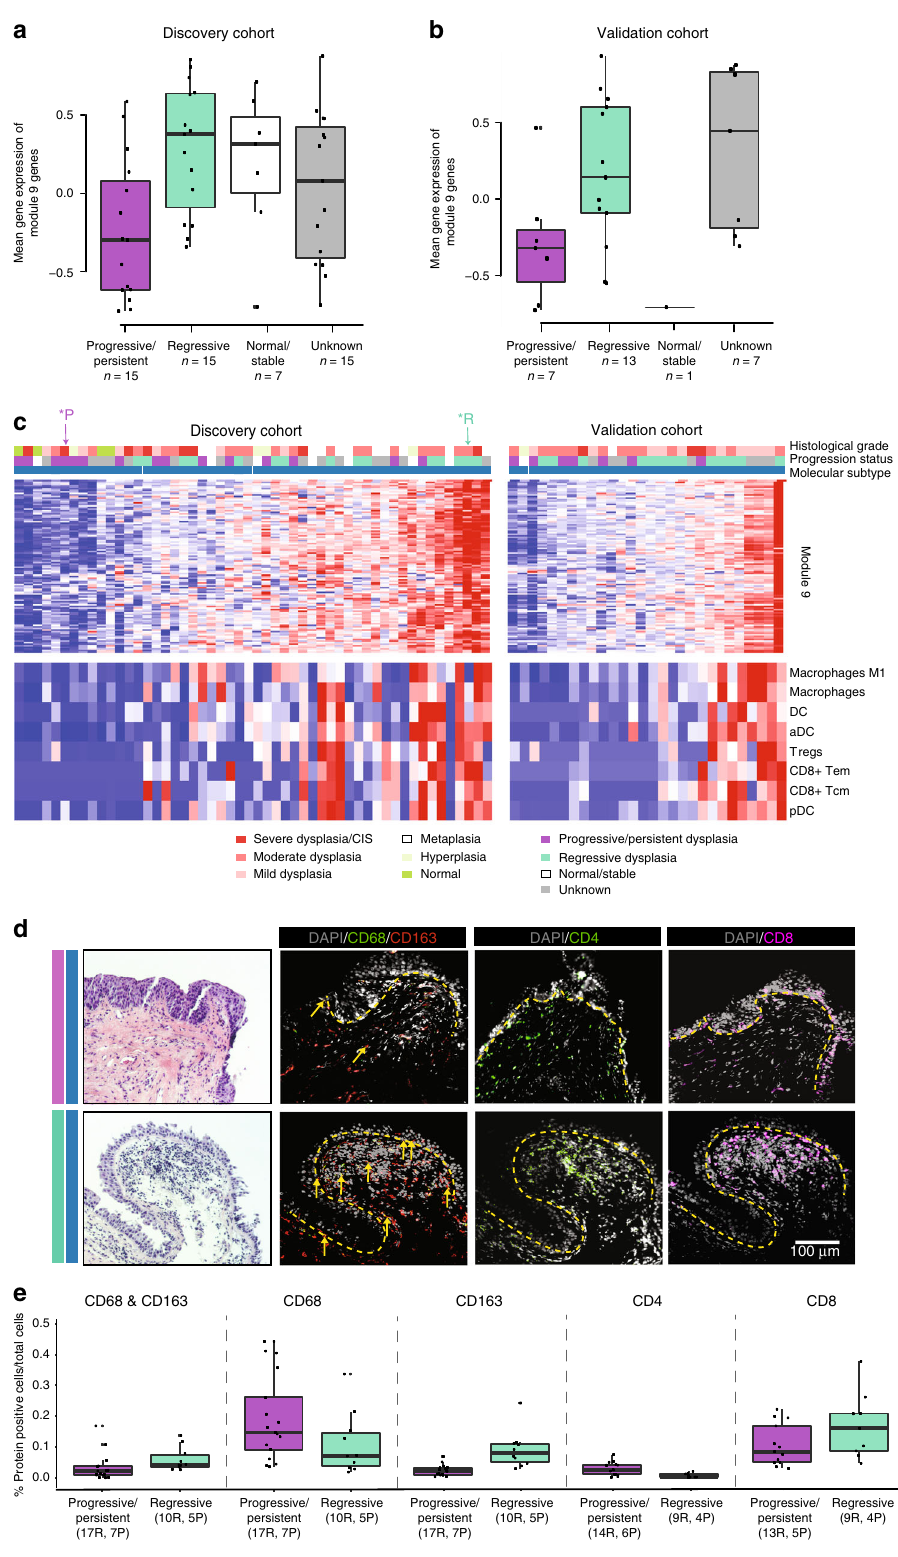
activated dendritic cells, plasmacytoid dendritic cells, macro- phages, M1 macrophages as well as CD8 + effector memory T cells, CD8 + central memory T cells, and T regulatory cells (Fig. 4c). Taken together, the progressive/persistent biopsies in the Proliferative subtype have down-regulated expression of Module 9 compared with regressive biopsies that correlates with